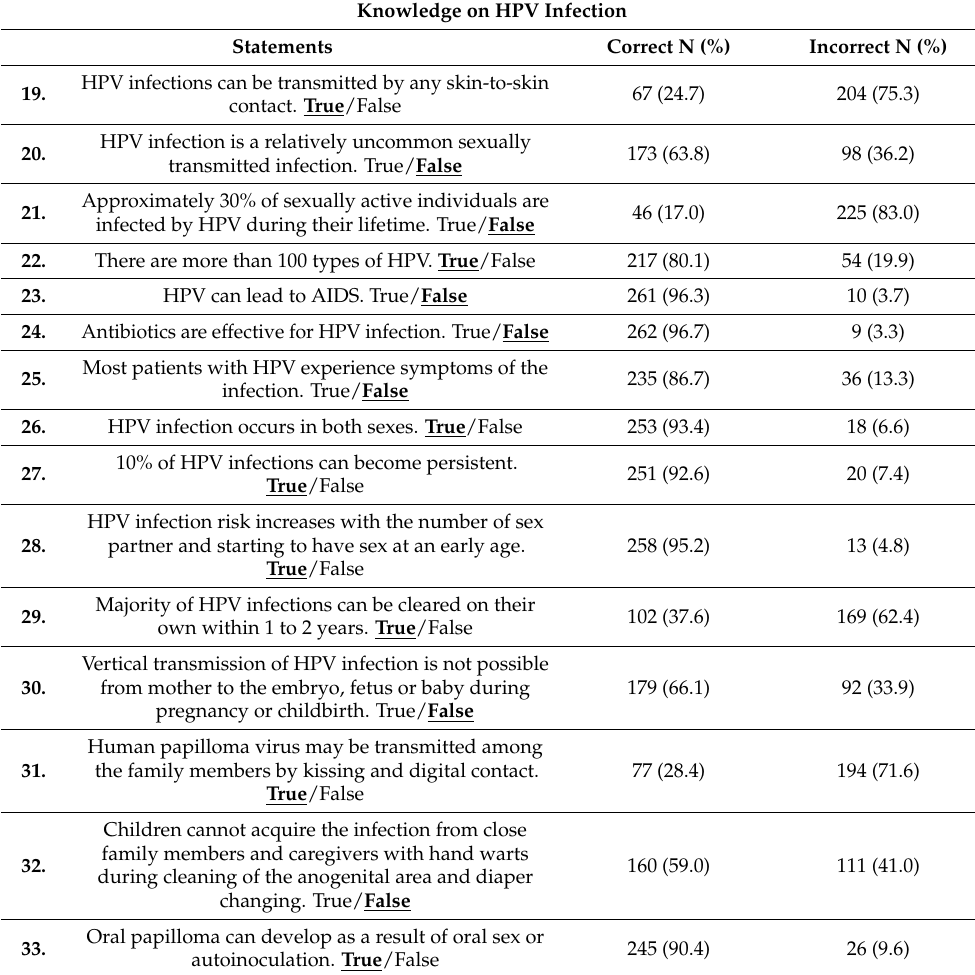
Table A2. Survey responses assessing pediatric dentists’ knowledge on HPV infection. Statements used